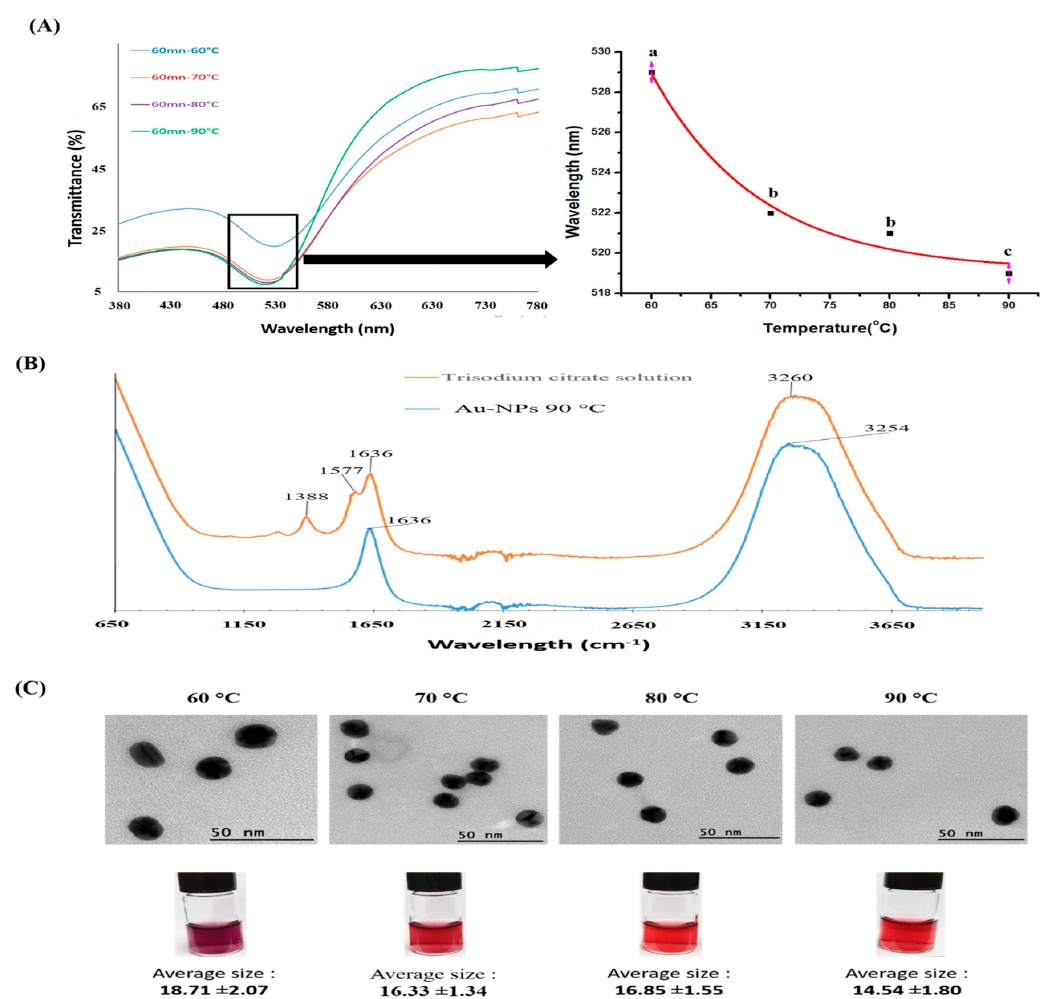
Figure 4. Optical characterization of gold nanoparticles (Au-NPs). ( A ) UV-vis transmittance spectra of Au-NPs colloidal solutions synthesized at high temperatures (60 to 90 °C) for 60 min. Results are expressed as mean ± SD, n = 3. Significant differences ( p < 0.05) are represented using different letters (a, b, c). ( B ) The Fourier-transform infrared spectroscopy (FTIR) spectra of trisodium citrate solution (88 g/L) and Au-NPs colloidal solution synthesized at 90 °C for 60 min. ( C ) TEM micrographs of gold nanoparticles synthesized at 60 °C, 70 °C, 80 °C, and 90 °C corresponding to the respective photography of Au-NPs colloidal solutions. The mean sizes of all four samples were determined by counting at least 100